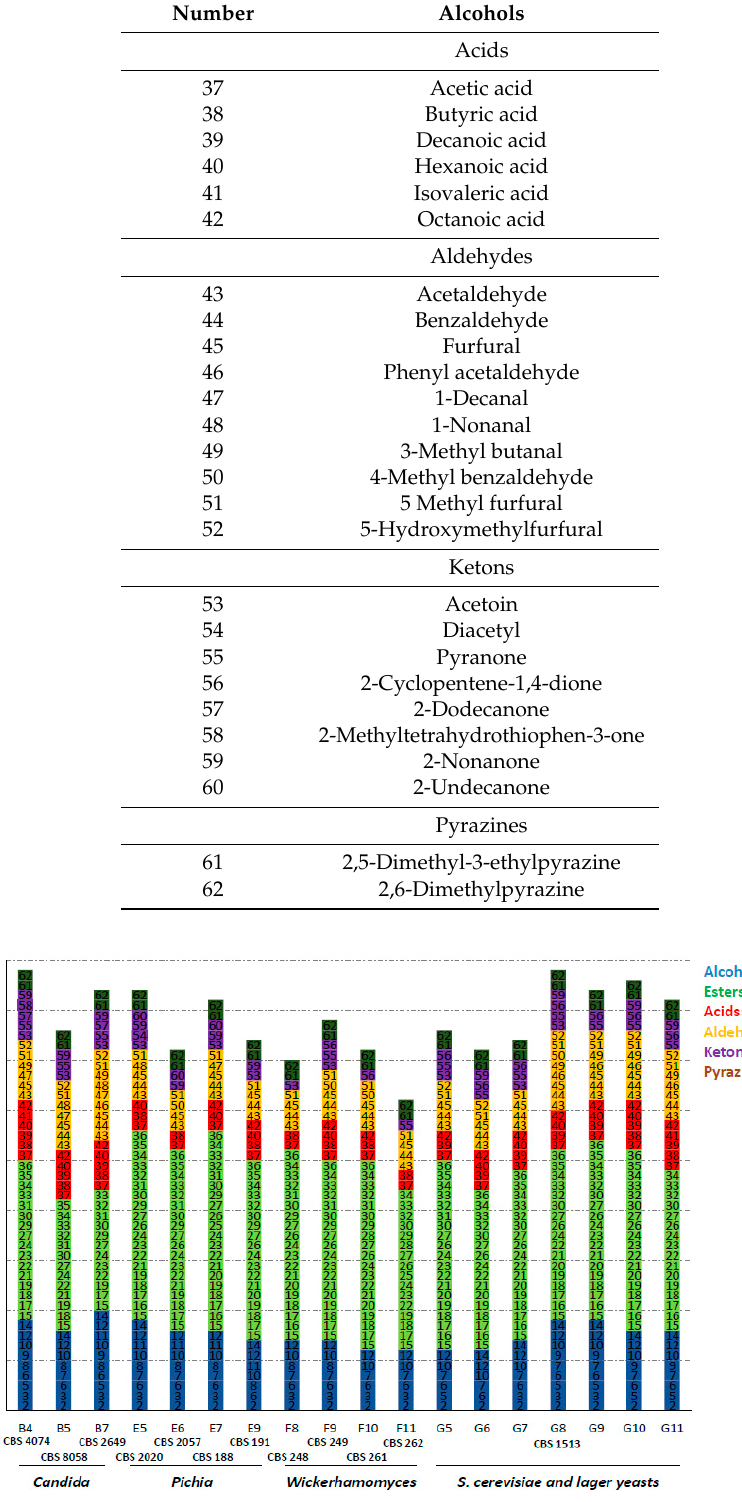
Figure 1. Number of volatile organic compounds (VOCs) produced during fermentation of selected strains. The compounds were grouped, numbered and colored according to their chemical class. The complete list of compounds is shown in Table S1 (see Table 1 for nomenclature of strains).